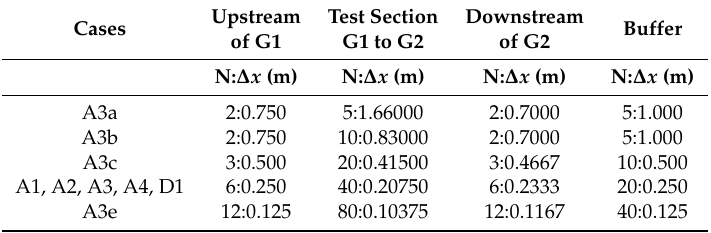
Table 4. Discretization of simulations. N is the number of cells in the section, ∆ x is the length of each